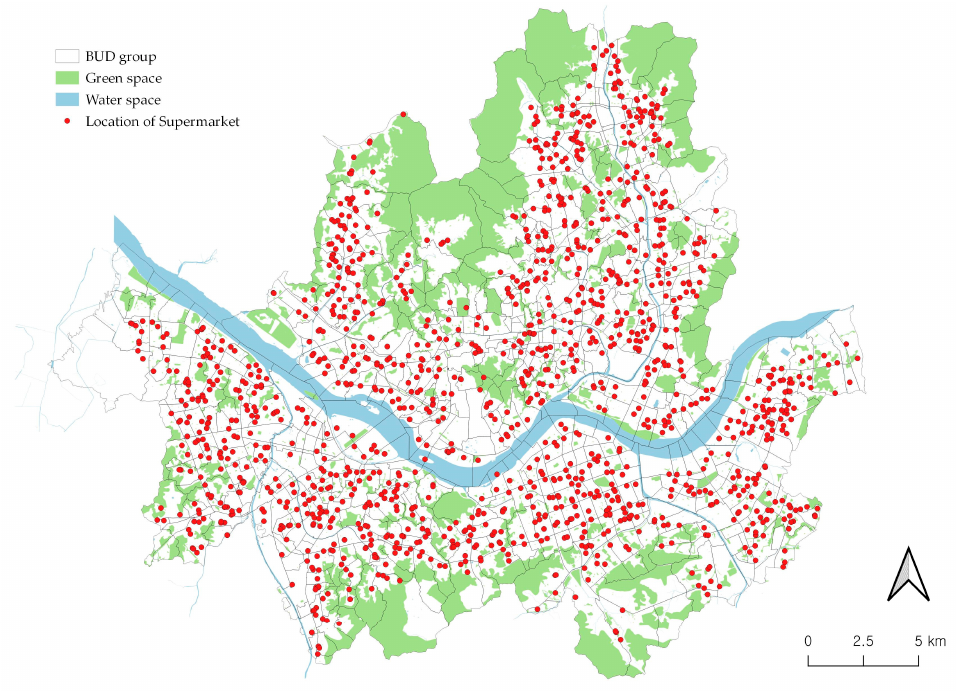
Figure 1. Study area and locations of supermarkets.